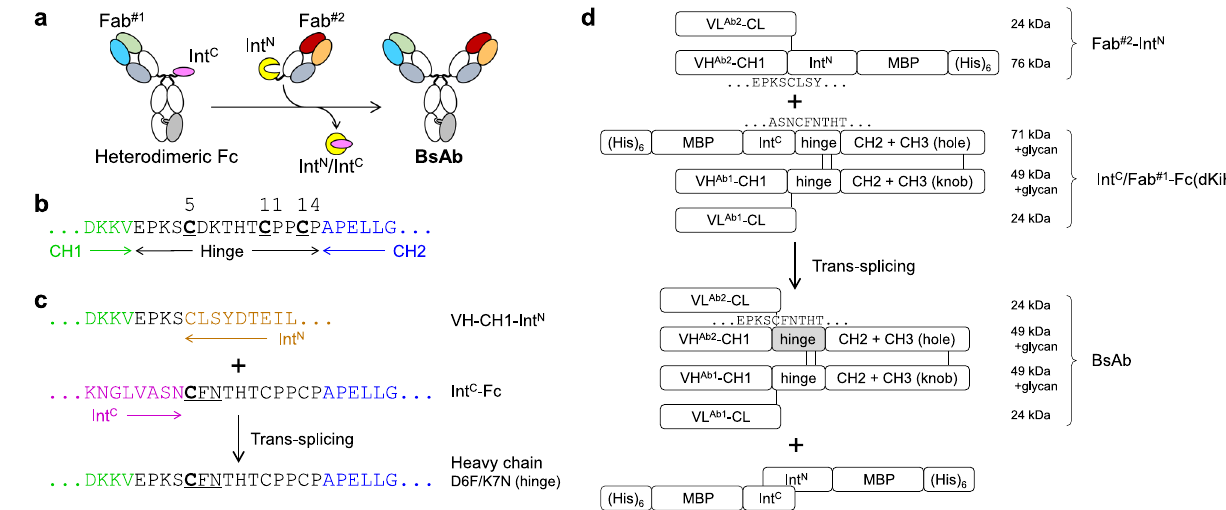
Figure 1. Design of polypeptides for intein-mediated protein trans-splicing (IMPTS). ( a ) General concept. ( b ) Sequence of the native hinge sequence of human IgG1. Cys residues (underlined) are numbered by the positions inside the hinge. ( c ) Designed IMPTS reaction to produce a native-like hinge sequence. Cys-Phe- Asn (underlined) mutated from the original Cys-Asp-Lys in the spliced product is optimal for IMPTS.